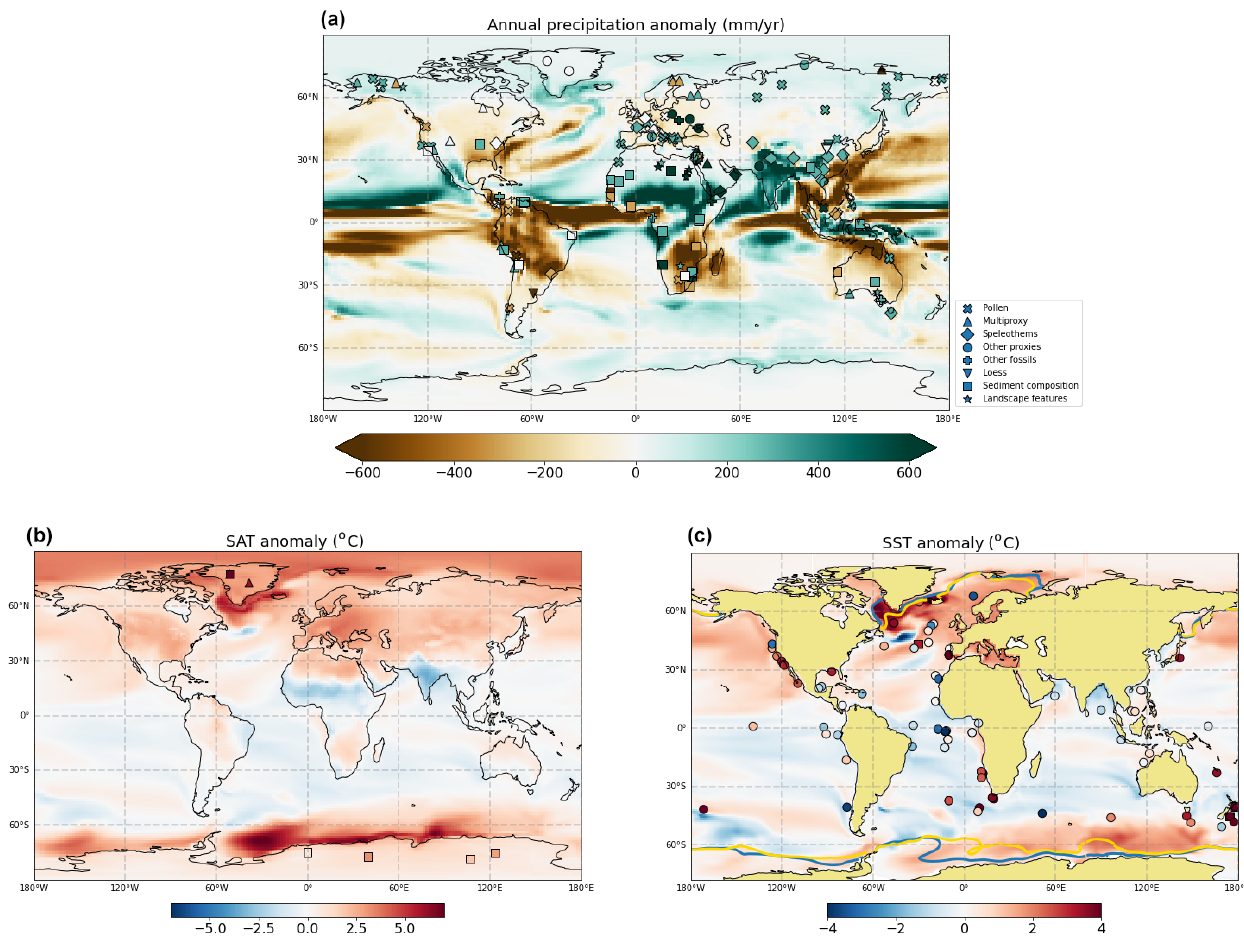
Figure 3. (a) Simulated annual mean precipitation anomaly (mmyr − 1 ) with proxy reconstructions from Scussolini et al. (2019) overlaid. Proxy reconstructions are semi-quantitative with much drier conditions shown in brown, drier in light brown and the reverse for green. (b) Annual mean surface air temperature anomalies ( ◦ C) with proxy data (filled markers: squares for the compilation by Capron et al., 2014, 2017; triangles for Arctic terrestrial proxies; Landais et al., 2016; NEEM community members et al., 2013; Yau et al., 2016). (c) Annual mean sea surface temperature anomalies with proxy data (filled markers: squares for the compilation by Capron et al., 2014, 2017; dots for the compilation by Hoffman et al., 2017), and contours of annual sea-ice concentration at 15% overlaid (blue: LIG; yellow: